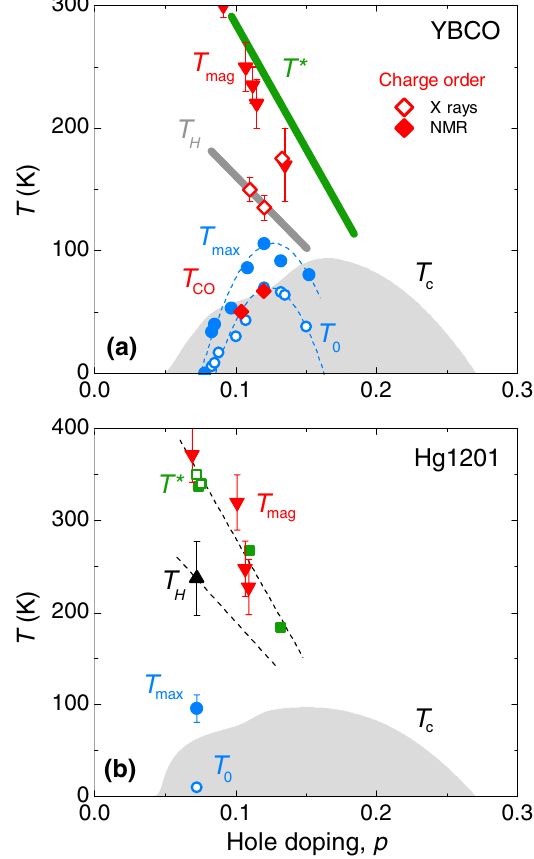
FIG. 3. (a) Temperature-doping phase diagram of YBCO, showing the zero-field superconducting phase below T c (grey dome, from Ref. [36]) and the onset of q ¼ 0 magnetic order detected by spin-polarized neutron scattering (down below T mag triangles, from Ref. [42]). Several characteristic temperatures of the transport properties are displayed: The thick green and grey lines schematically represent the pseudogap temperature T ? , from resistivity and Nernst data [23], and T H , from R H ð T Þ [19], re- (full circles) and T (empty circles) are deter- spectively. T max 0 mined from R H ð T Þ [19] (see text). We also show the onset of via NMR (full diamonds, from Ref. [13]) and charge order at T CO the approximate onset of charge modulations via x-ray scattering (open diamonds, from Refs. [14–16]). (b) Corresponding phase diagram for Hg1201, showing T c (grey dome, from Ref. [22]), T (down triangles, from Refs. [39,40]), and T ? from resistivity mag (full squares, from Refs. [21,39,40]; open squares, from this (full circles) and T work). The characteristic temperatures T max 0 (empty circles) of R H ð T Þ are also shown. All dashed lines in both panels are a guide to the